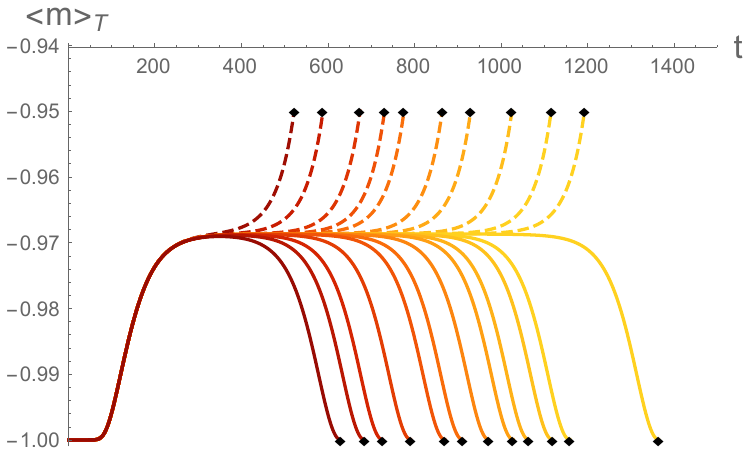
Figure 11 . Build-up processes leading to a TMS that starts pulsating upward (dashed) and downward (solid) as (cid:12) ! (cid:12) c . Dashed simulations have been stopped when h m i (cid:12)rst time. On the other hand, solid simulations have been cut when h m i after the build-up